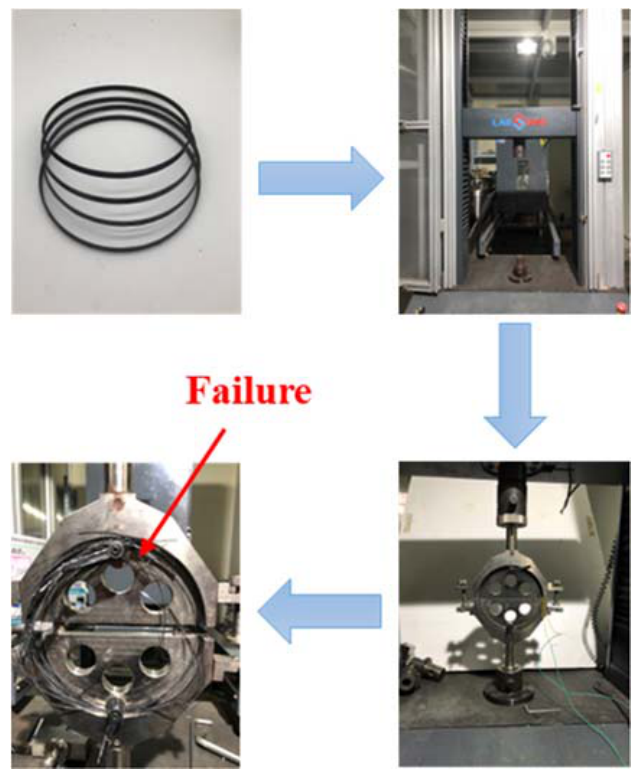
Figure 5. NOL ring tensile test.